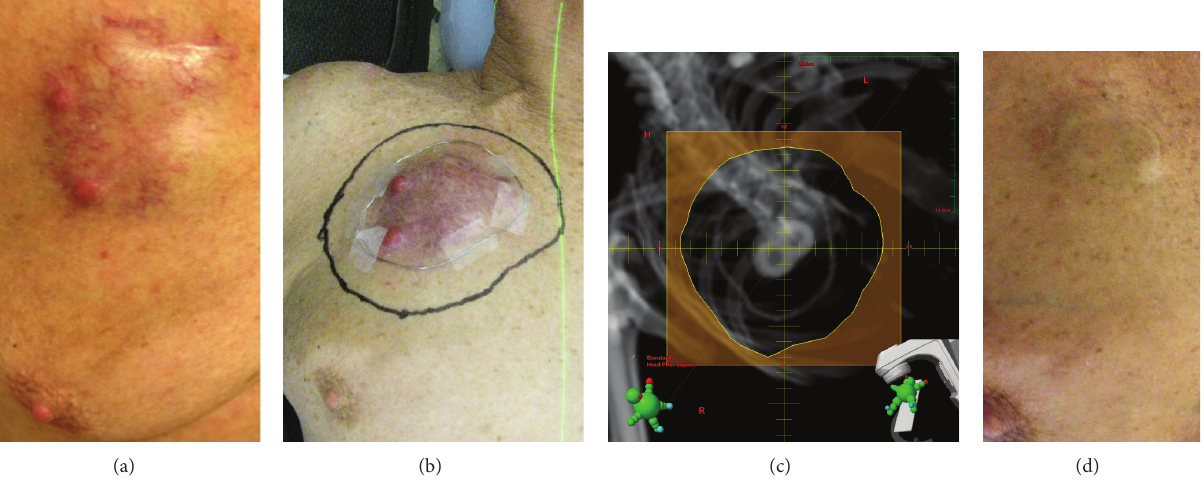
Figure 3: Secondary cutaneous plasmacytoma presenting as (a) nodularity on violaceous background overlying Port-A-Cath on patient’s anterior right chest wall. (b) Treatment positioning with outlined target and (c) en face field with custom block on simulation image. (d) Full resolution of lesions observed one month after